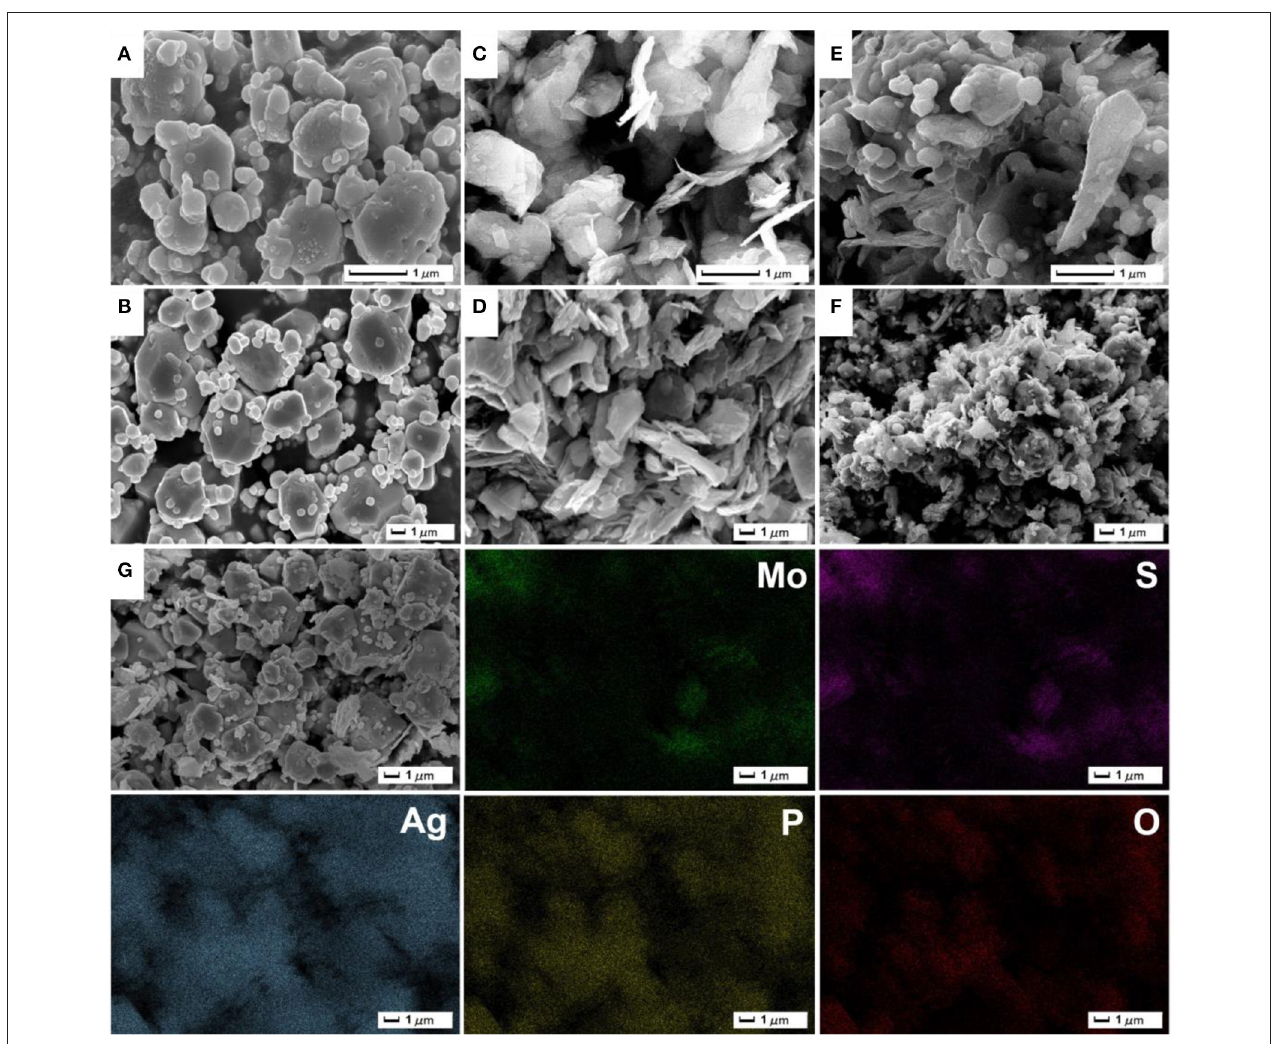
FIGURE 3 | Low-magnification (A,C,E) and high-magnification (B,D,F) SEM images of pure Ag 3 PO 4 (A,B), MoS 2 (C,D) as well as the composite AM-200 (E,F) ; EDS element mapping images of AM-200 (G) .